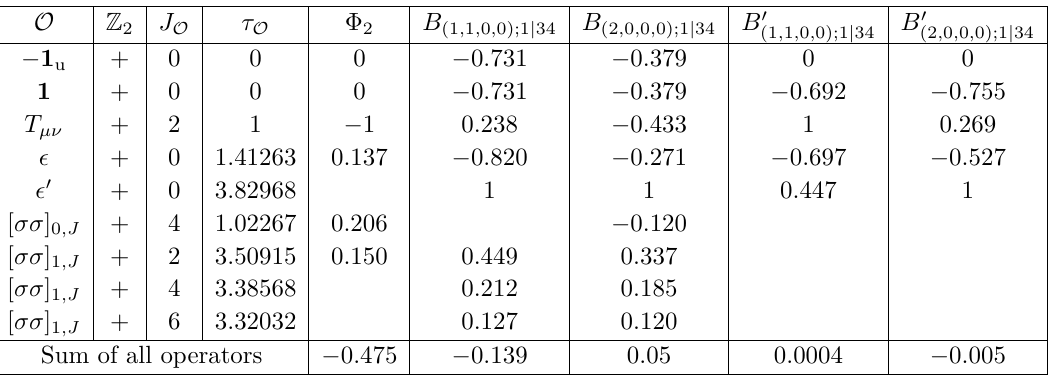
Table 6 . Contribution of each operator to the h (cid:15)(cid:15)(cid:15)(cid:15) i sum rule with v = 1 ; these results include the contribution of the OPE coefficient square f 2 . Empty cells and all other operators contribute at (cid:15)(cid:15) O order O (10 − 2 ) and smaller. Finally, the sum of all operators must add up to 0 in accordance with eq.